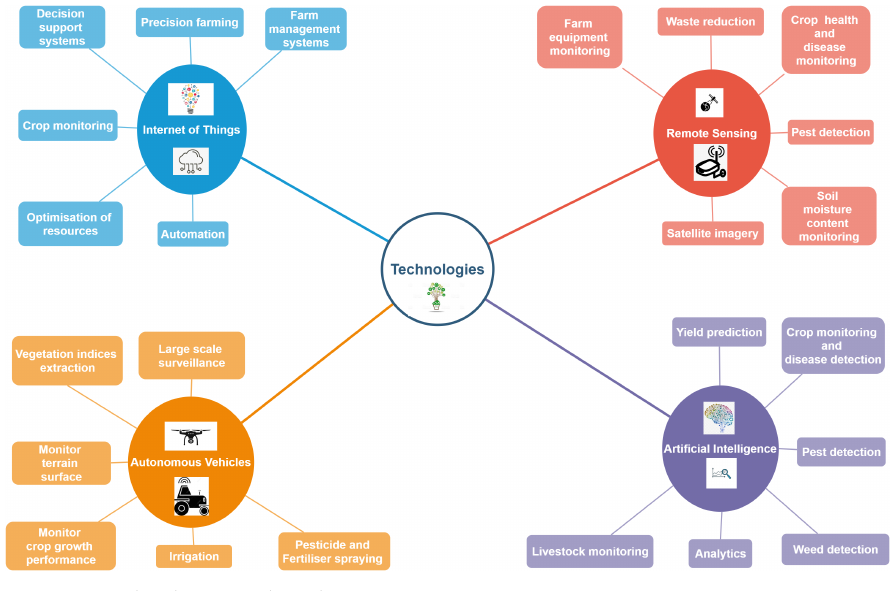
Figure 3. Technologies and applications. Table 1. Overview of ICTs in smart